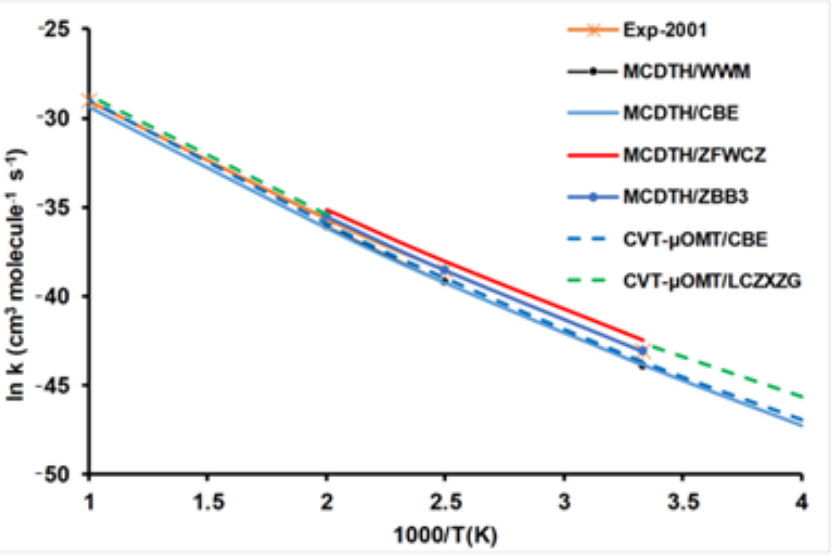
Figure 2. Arrhenius plots of the rate constants (cm 3 molecule − 1 s − 1 ) for the H + CH 4 reaction using different kinetics methods and PESs, together with experimental values for comparison. See text for acronyms.